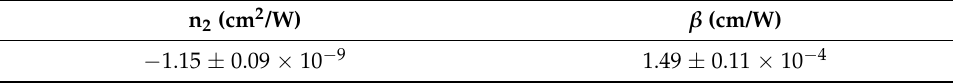
Table 3. The NLO constants n 2 and β of the synthesized CNPs.